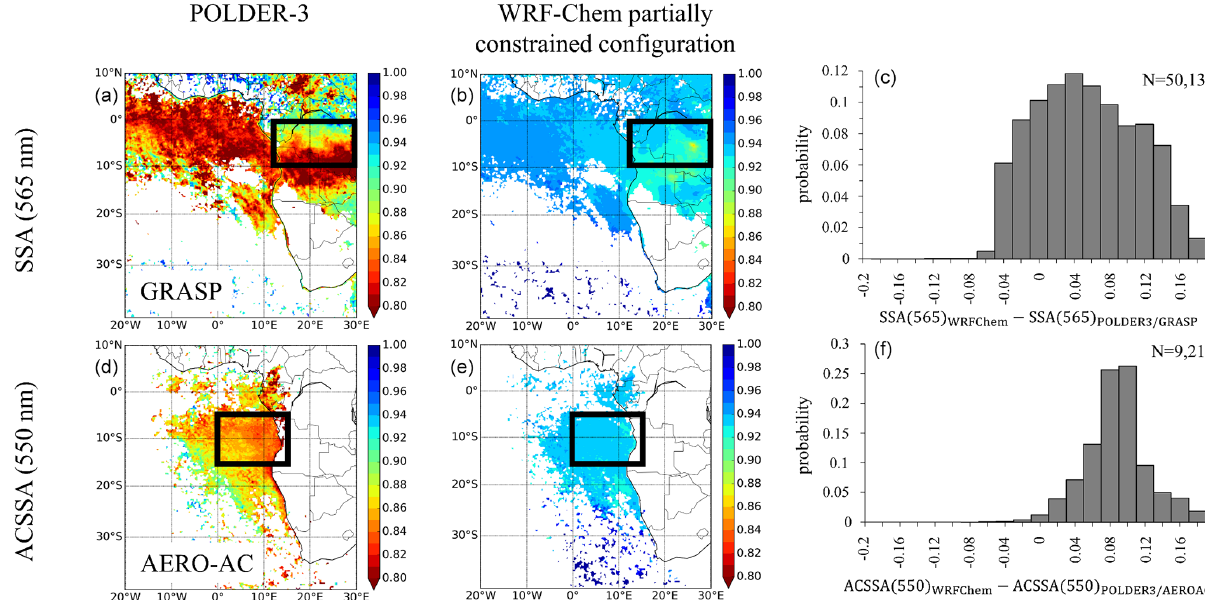
Figure 13. Monthly averaged single scattering albedo of aerosols at 565nm in clear sky (a, b) and at 550nm above clouds (d, e) retrieved by POLDER-3 (a, d) and simulated with the WRF-Chem partially constrained configuration (b, e) for July 2008, with the associated histograms of differences between the model and the satellite observations over the whole domain (c, f) . The black frames (12–30 ◦ E, 10–0 ◦ S) and (0–15 ◦ E, 15–5 ◦ S) represent respectively the two study regions, in clear sky (a, b) and above clouds (d, e)